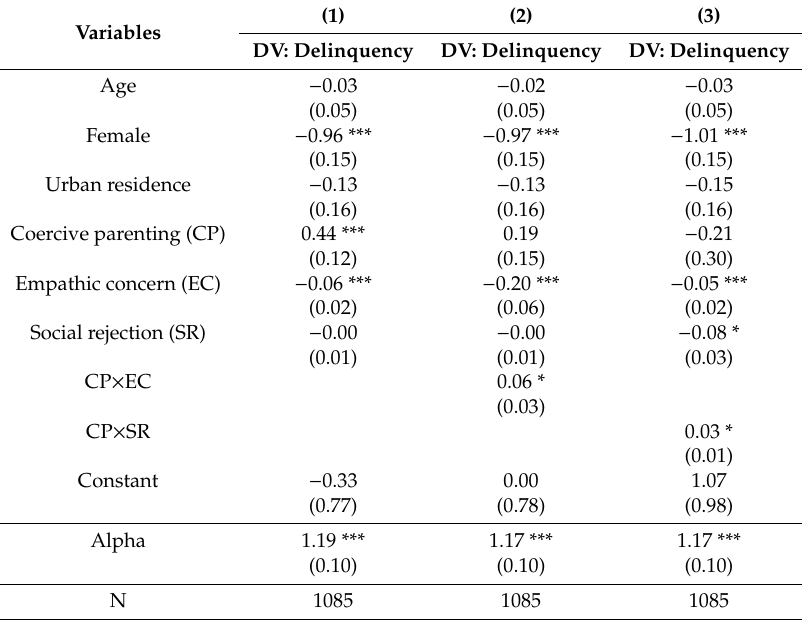
Table 3. Regression coe ffi cients of explanatory variables on delinquency.